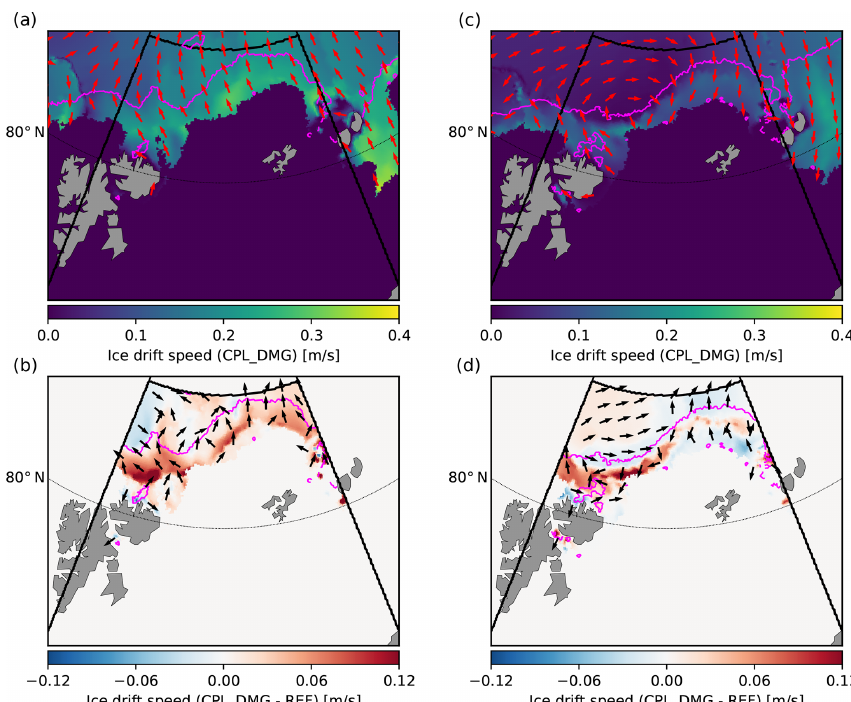
Figure 13. Snapshots of the distributions of sea ice drift velocity in the CPL_DMG simulation (a, c) and of the differences in sea ice drift velocity between the CPL_DMG and REF simulations (b, d) in the Barents Sea taken on 16 October 2015 at 18:00:00GMT (a, b) and on 21 October 2015 at 09:00:00GMT (c, d) . The green line delimits the area with compact sea ice (defined as c ≥ 0 . 8) in CPL_DMG. The magenta line corresponds to the contour D max = 200m in CPL_DMG. The black thick lines delimit the domain used to analyse the results from the three simulations (REF, CPL_WRS, CPL_DMG) in Figs. 9, 12 and